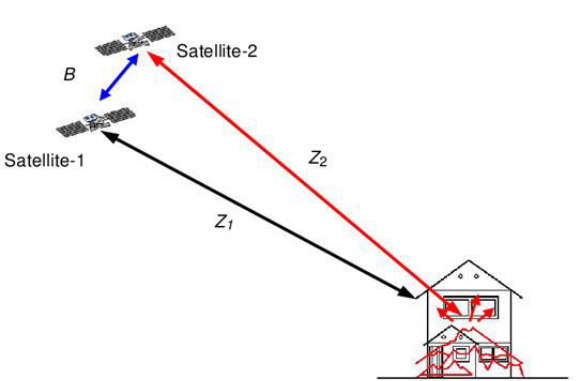
Figure 1. Repeat Pass Interferometry (Matsuoka & Yamazaki, 2000)